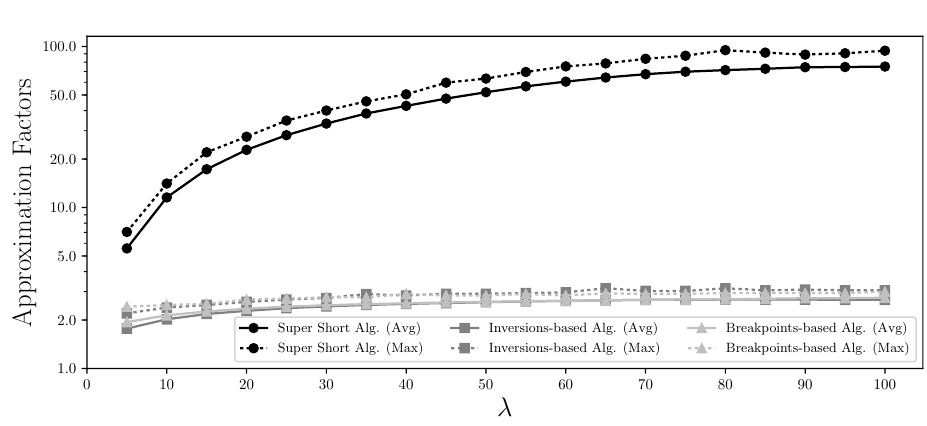
Breakpoints-based Alg. (Avg) Breakpoints-based Alg. (Max)